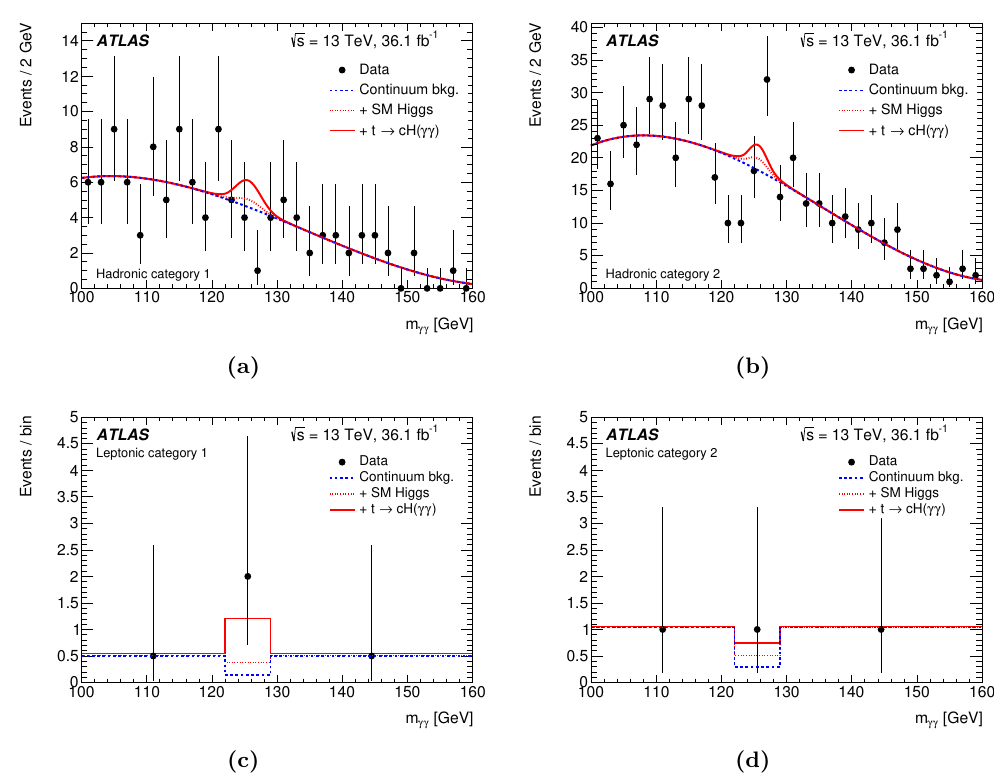
Figure 6. Distributions of m (cid:13)(cid:13) for the selected sample in the (a) hadronic category 1, (b) hadronic category 2, (c) leptonic category 1 and (d) leptonic category 2 channels. The result of (cid:12)tting the data with the sum (full line) of a signal component with the mass of the Higgs boson (cid:12)xed to m H = 125 : 09 GeV, a continuum background component (dashed line) and the SM Higgs boson contribution (di(cid:11)erence between the dotted and dashed lines) is superimposed. The leptonic categories have only two bins: the seven-GeV-wide SR and the CR (see text). The CR region bin extends from the signal region to both higher and lower masses; the content of the CR is shared equally between the low- mass part (100 GeV to 122 GeV) and the high-mass part (129 GeV to 160 GeV) of the CR